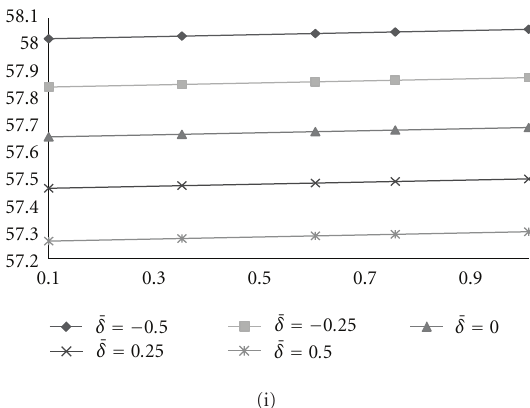
Figure 2: (a)–(i) The distribution of load-carrying capacity with respect to the magnetization parameter μ ∗ for various values of surface roughness σ , ε , aspect ratio m , porosity ψ , curvature parameters B , C , rotational inertia s/κ and elastic deformation δ